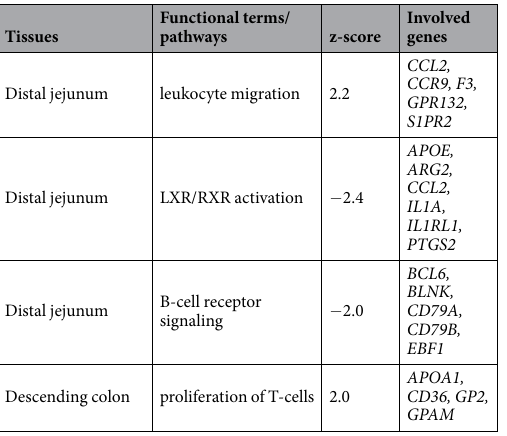
Table 3. IPA downstream functional analysis and pathways analysis for DE genes between non-shedders and super-shedders in distal jejunum, cecum, and descending colon, no functional terms or pathways with |z| ≥ 2 were enriched for the other